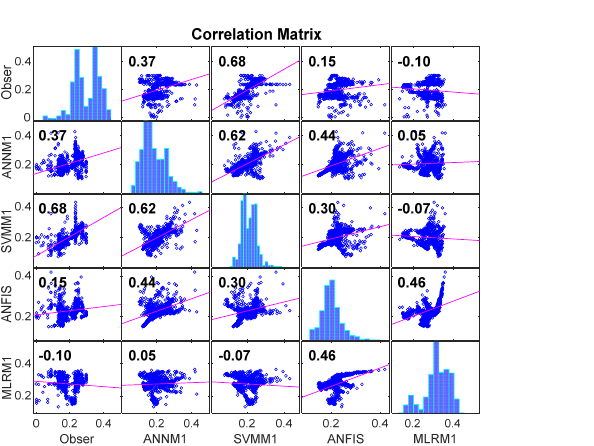
Figure 11. The marginal internal correlation plot between the observed and predicted models in the validation phase.